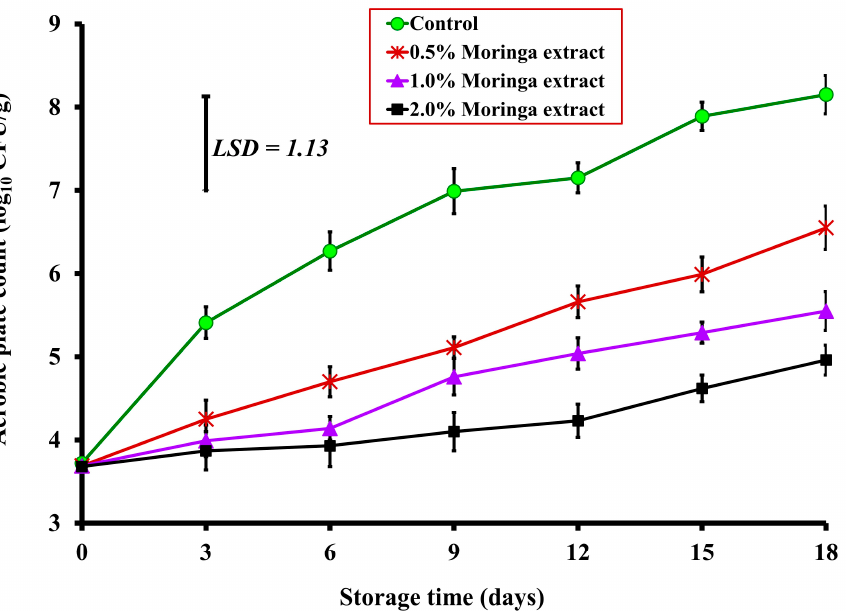
Figure 1. Effect of Moringa oleifera leaves extract supplemented to ground beef on the aerobic plate count (APC) (log 10 CFU/g) during cold storage at 4 °C for 18 days. The displayed values represented count (APC) (log 10 CFU/g) during cold storage at 4 ◦ C for 18 days. The displayed values represented the mean of triplicate measurements ± standard error (SE). the mean of triplicate measurements ± standard error